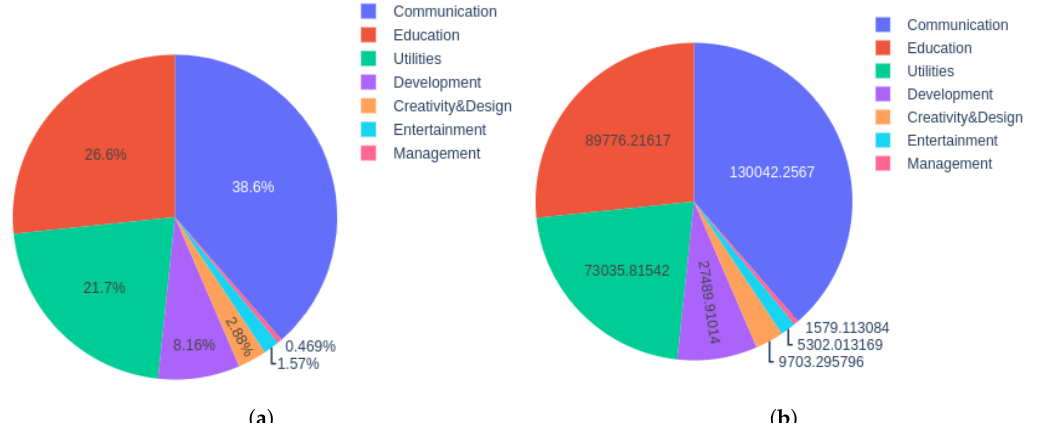
Figure 7. Results of data analysis. ( a ) CPU usage in percentage for all categories; ( b ) CPU usage in Wt for each category.